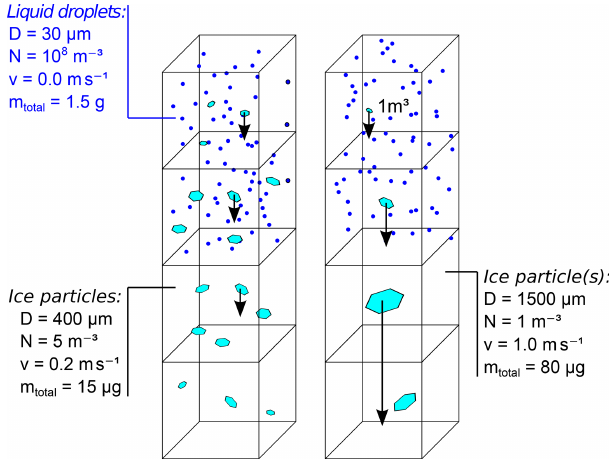
Figure 1. Comparison of two clouds with different ice crystal num- ber concentrations N but with the same ice crystal number flux, F = 1m − 2 s − 1 ( F = N × v t with v t terminal fall velocity), and, hence, also the same rate of ice production. The left column shows higher ice crystal number concentration ( N ) but less total ice mass, and the right column shows lower N and higher total ice